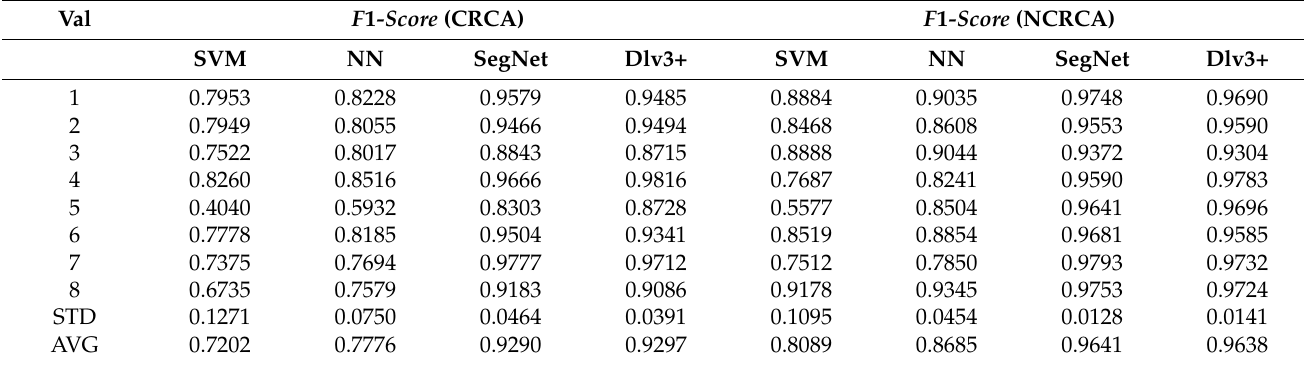
Table 6. Comparison of SVM, NN, SegNet, and Dlv3+ on pixel-wise